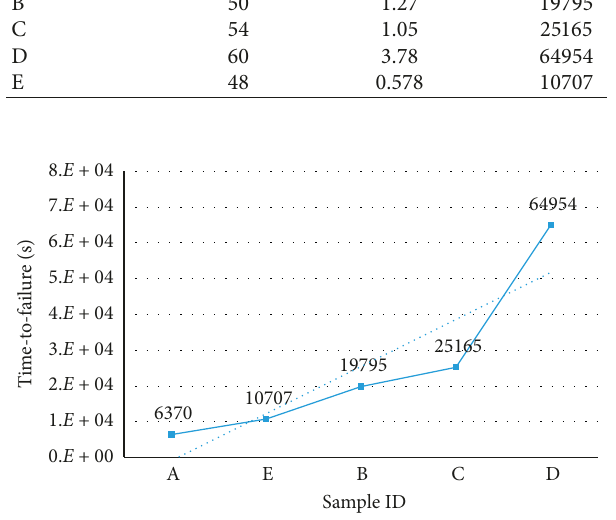
Figure 7: Time-to-failure of failed samples in ascending order for 35V 22 μ F chip tantalum capacitors after 1.6xVr at 85 ° C for 100,000 s.